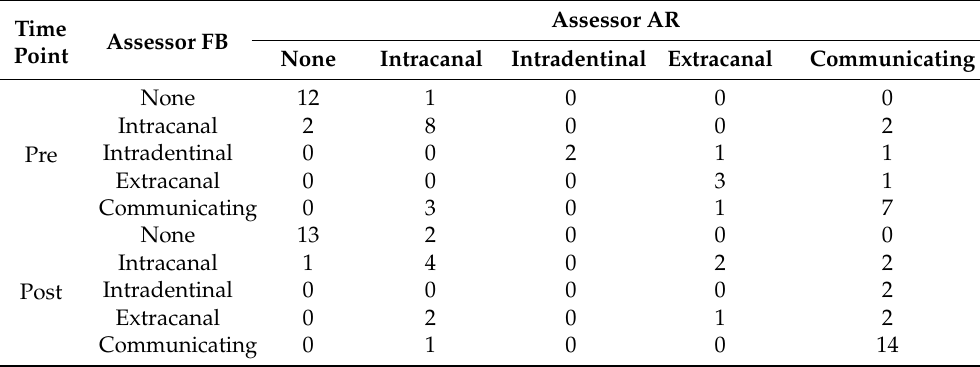
Table 1. Crosstabulation of the different crack modalities between the assessors according to the time